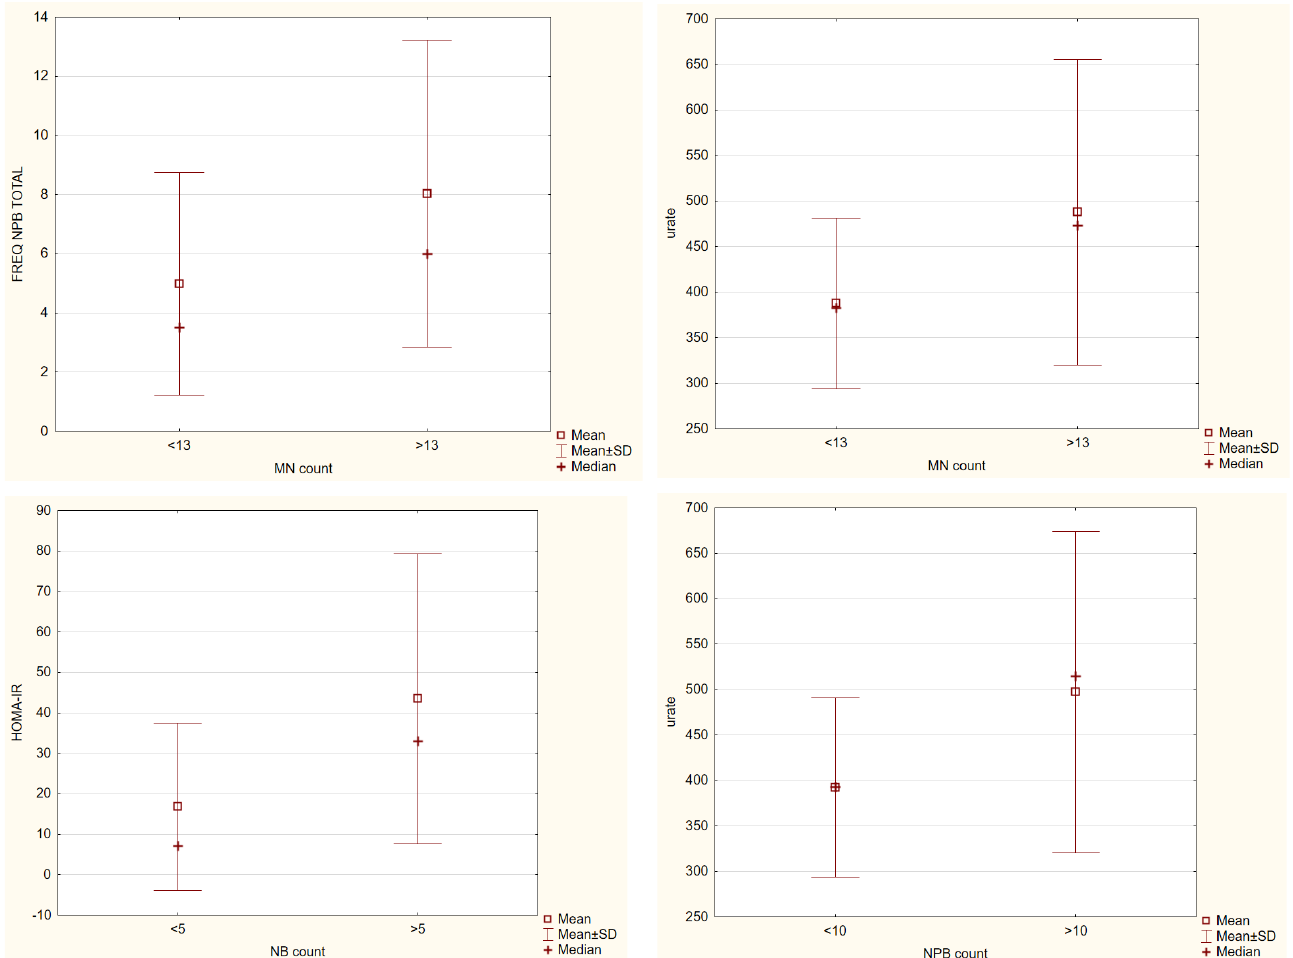
Figure 6. Significant differences in biochemical parameters among groups with higher or lower DNA damage parameters in both comet and micronucleus cytome assay, Mann–Whitney U test, p ≤ 0.05.